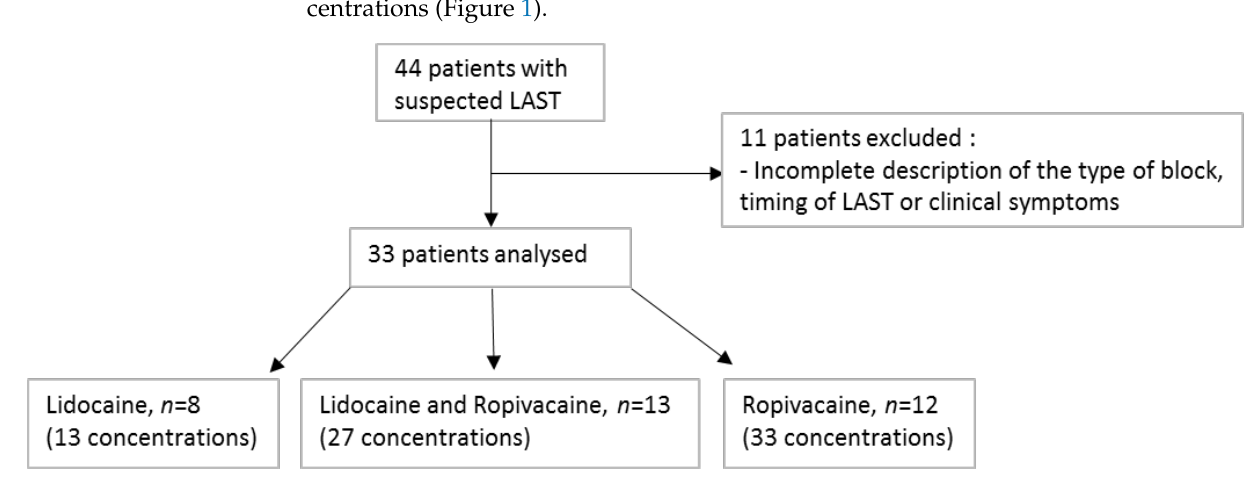
Figure 1. Flowchart of the study.